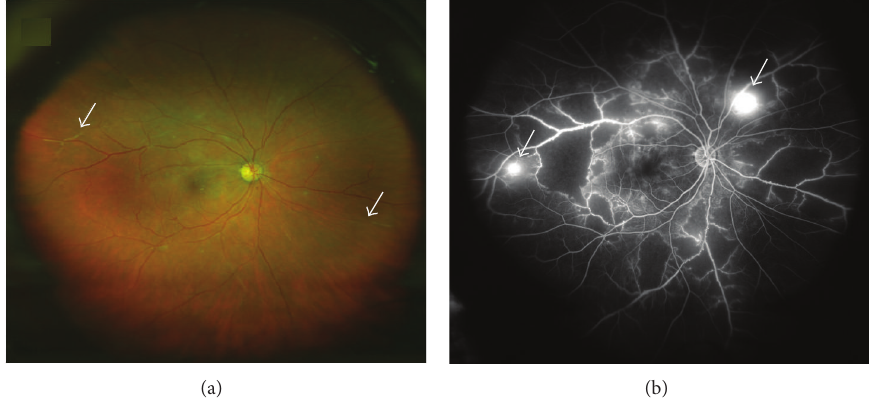
Figure 4: Fundus photographs of SLE associated occlusive retinal vasculitis. (a) Color images demonstrating vascular sheathing (arrows). (b) Fluorescein angiography shows multiple areas of capillary dropout at the retinal midperiphery with leakage from retinal neovasculariza- tion